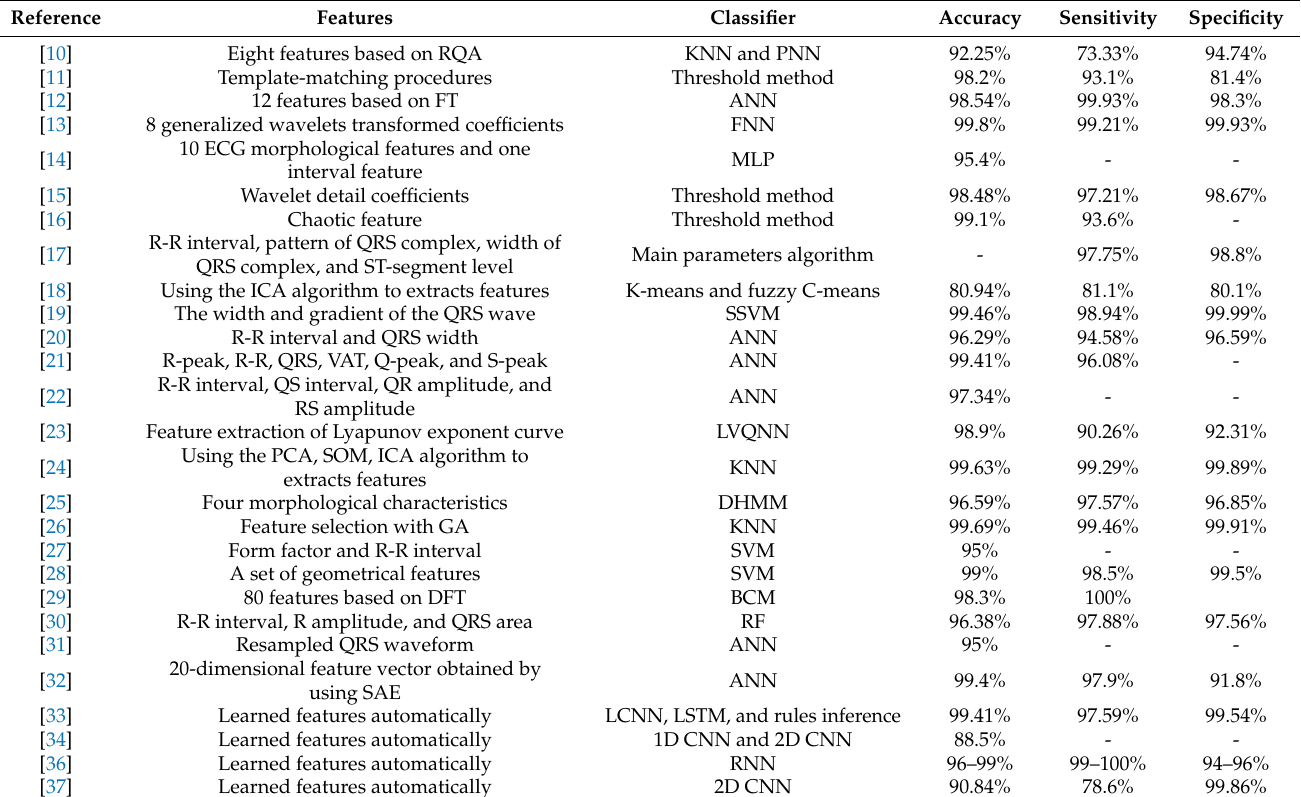
Table 4. Some algorithms for detecting